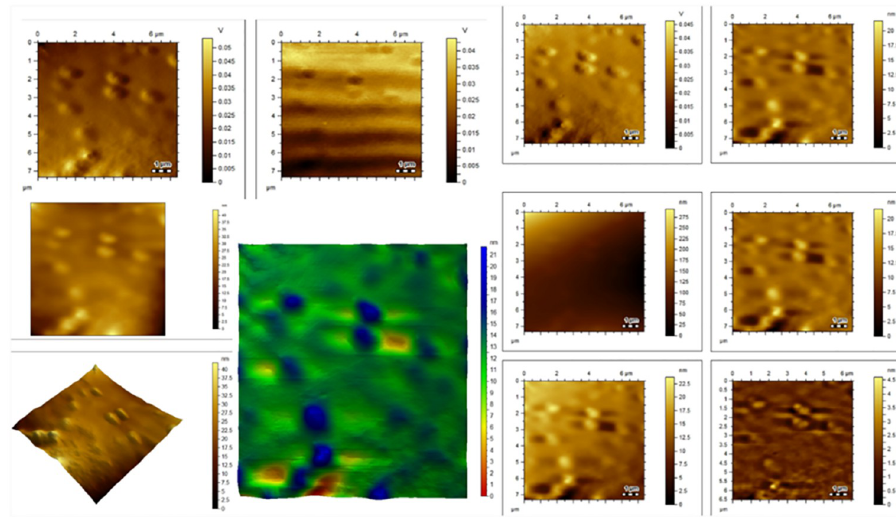
Fig 5. AFM images of Thyme based silver nanoparticles (T/AgNPs). “The AFM images display dense aggregates of quasi-spherical AgNPs with an average size of 22 nm. The aggregation shown in AFM images is attributed to the sampling process for AFM leading to dropping a few drops of NPs solution on a silica glass plate and allowing drying to get a thin film of NPs. This will allow the NPs to be clustered together. The AFM images confirm the narrow particle size distribution obtained from TEM images”.